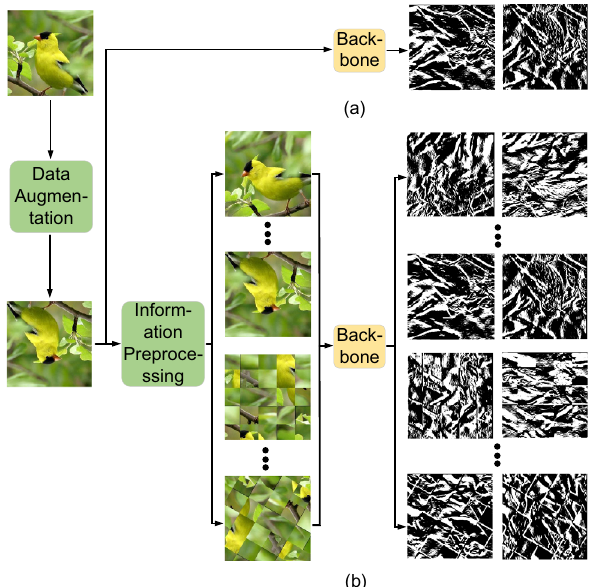
Figure 3. Examples of the LSI extraction. ( a ) LSI extraction of the existing image data augmentation technique. ( b ) LSI extraction of our proposed information